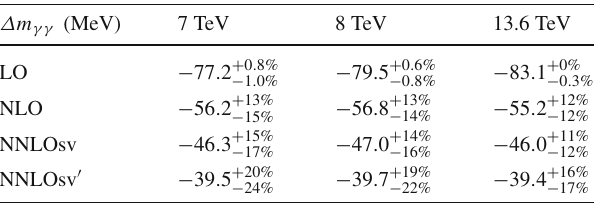
Table 1 Mass-shift at different proton-proton collider energies with Gaussian fit method